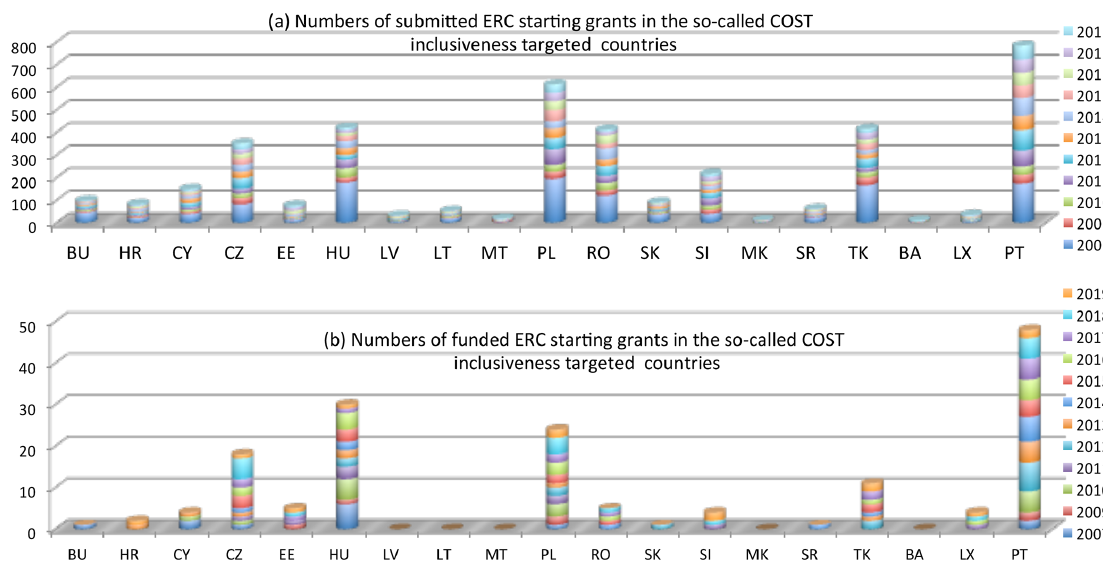
Figure 1. Numbers of submitted (a) and funded (b) ERC starting grants in the so-called COST inclusiveness targeted